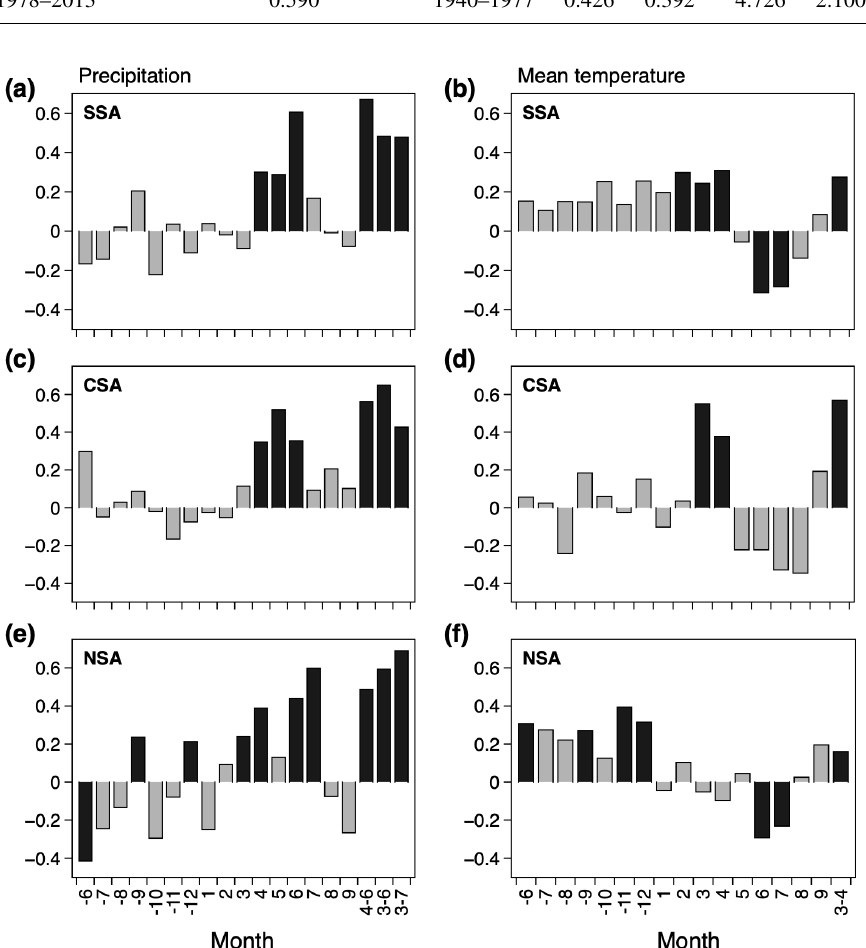
Figure 4. The correlation between the meteorological data (total precipitation and mean temperature) from Chuguyevka meteorological station and SSA tree-ring width index (a, b) , Mel’nichoye meteorological station and CSA tree-ring width index (c, d) , and Krasnyy Yar meteorological station and NSA tree-ring width index (e, f) . Black bars denote significant values ( α = 0 .